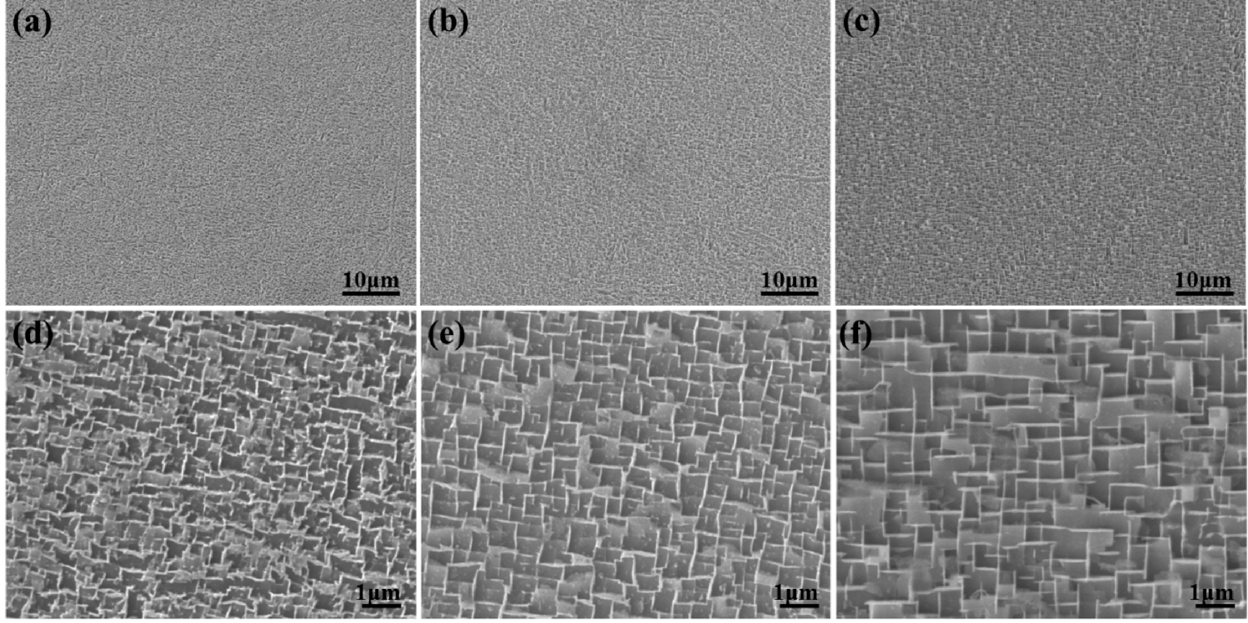
Figure 3. The SEM-SE morphology of secondary γ′ phases after heat treatment under different cooling rates: ( a , b ) WQ, ( d , e ) AC and ( c , f ) HT.